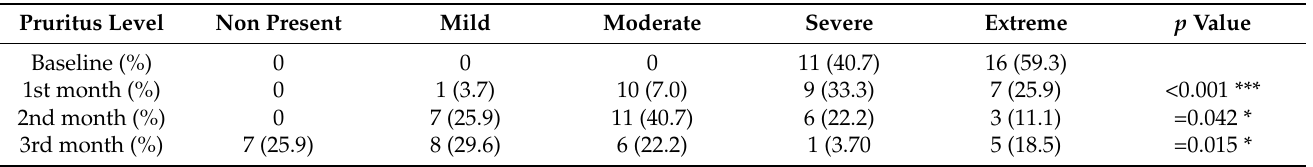
Table 4. Comparison of pruritus levels before and after daily EPA supplementation in hemodialysis patients (mean ±